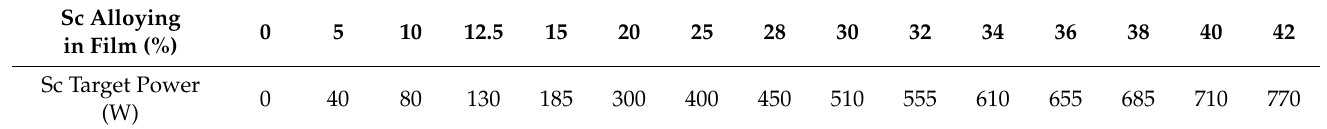
Table 3. Scandium concentration vs. Sc target